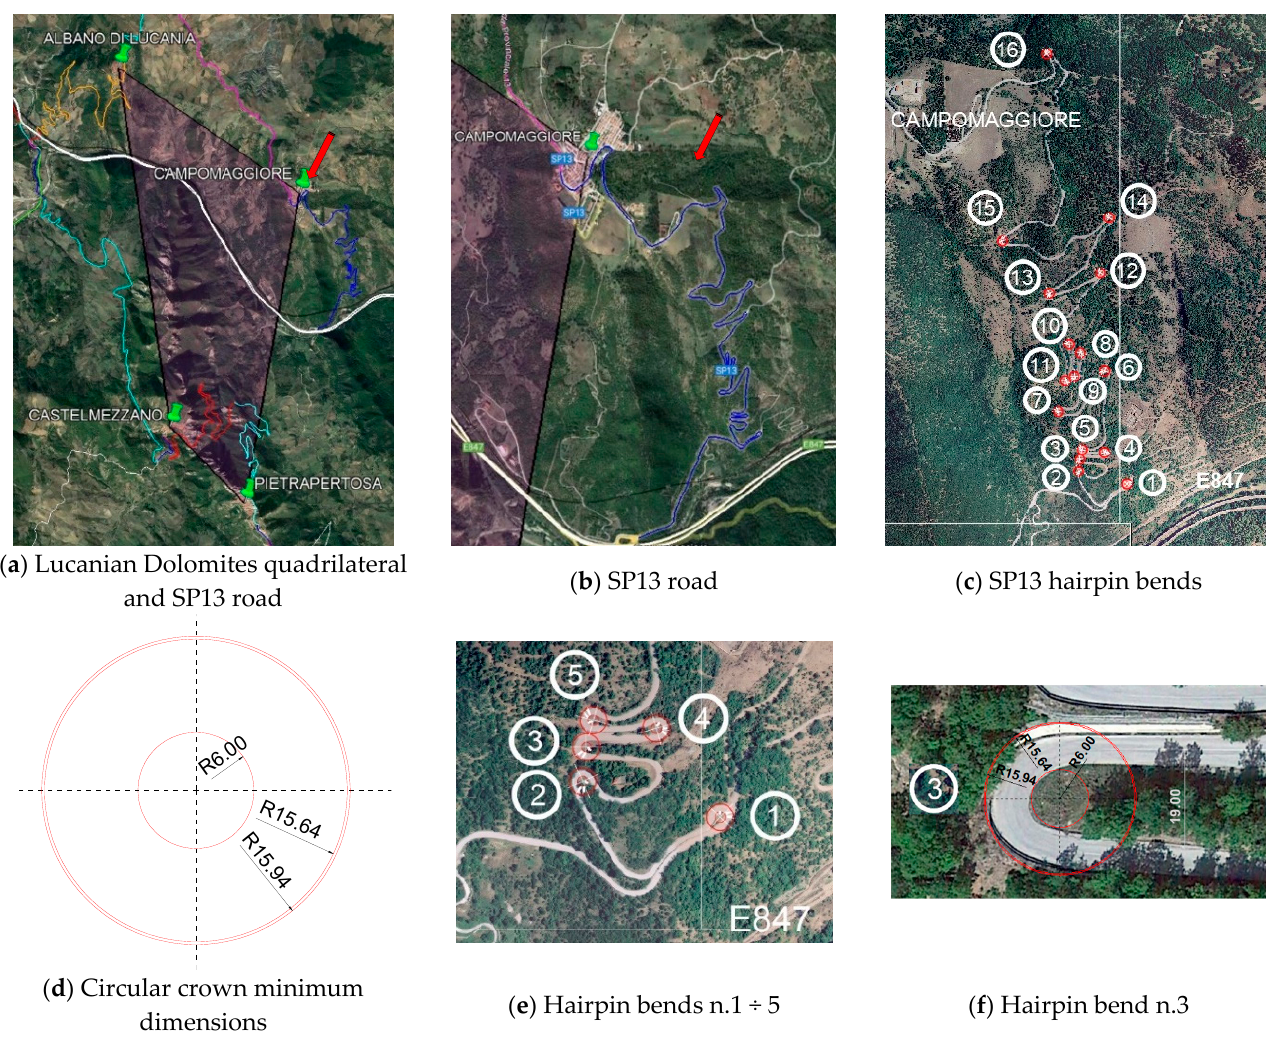
Figure 9. Hairpin bend n.3 location on SP13 road.